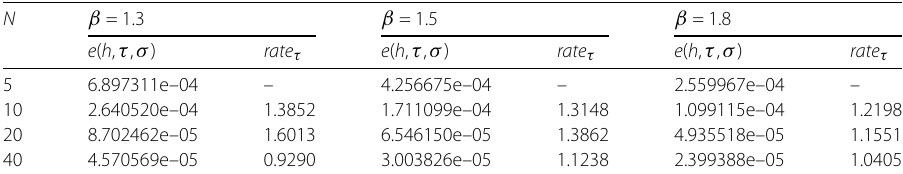
Table 2 Maximum errors and temporal convergence orders of difference scheme (2.14)–(2.16) for